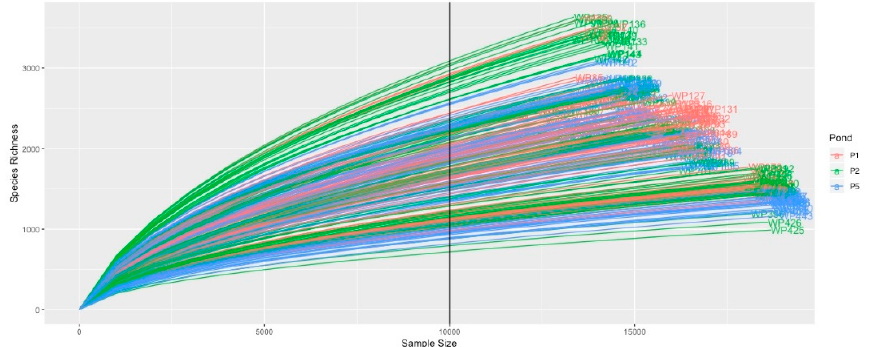
Figure A1. Sample rarefaction curves. Colors indicate pond number. P1 = Pond 1, P2 = Pond 2 and P5 = Pond 5.